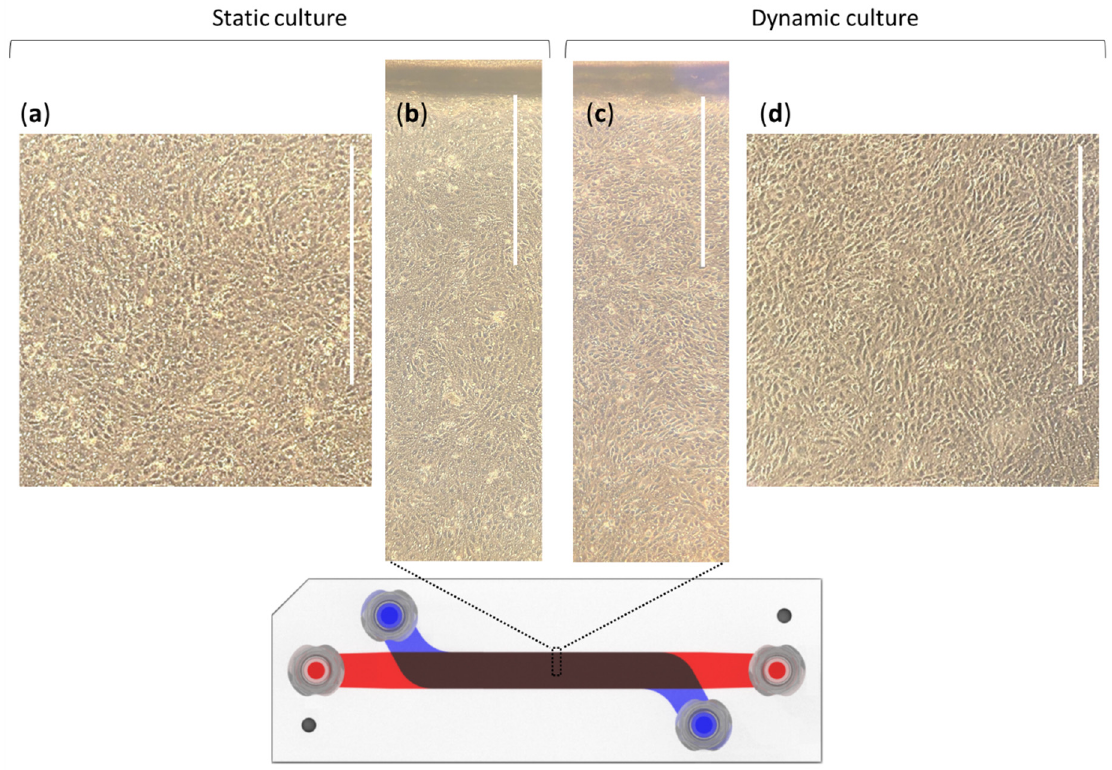
Figure 3. Phase contrast microscopic views of the static and dynamic (10 dyn · cm − 2 ) cultures of hCMEC/D3 cells after seven days in the barrier device; ( a , d ) images were taken from the center of the channels, while ( b , c ) were viewed at the edges. These images are representative of four independent experiments. Scale bars represents 1 mm.